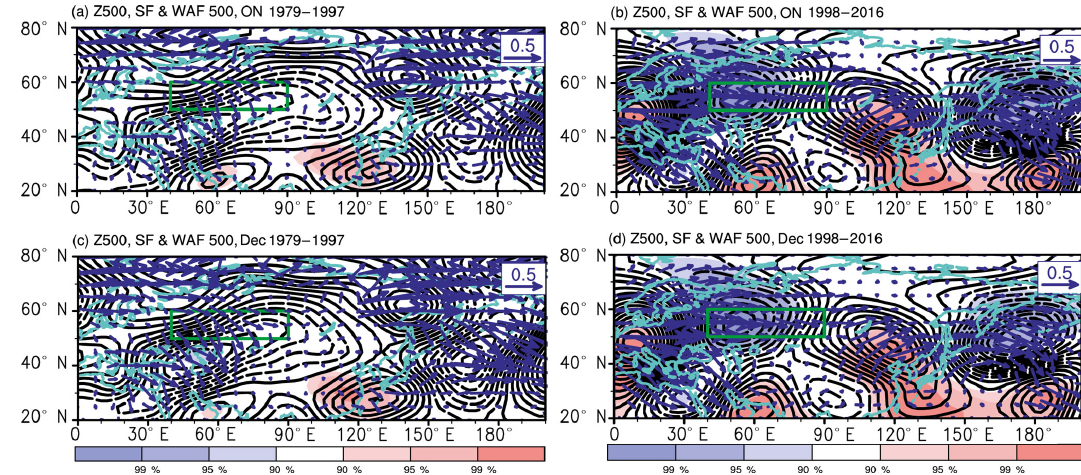
Figure 10. The CC between the SoilM index and Z500 (shading, exceeding 90, 95, and 99% confidence levels), stream function (contour), and wave activity flux (arrow) in (a) October–November and (c) December from 1979 to 1997 and in (b) October–November and (d) December from 1998 to 2016. The green box represents the ES area. The linear trend is removed.